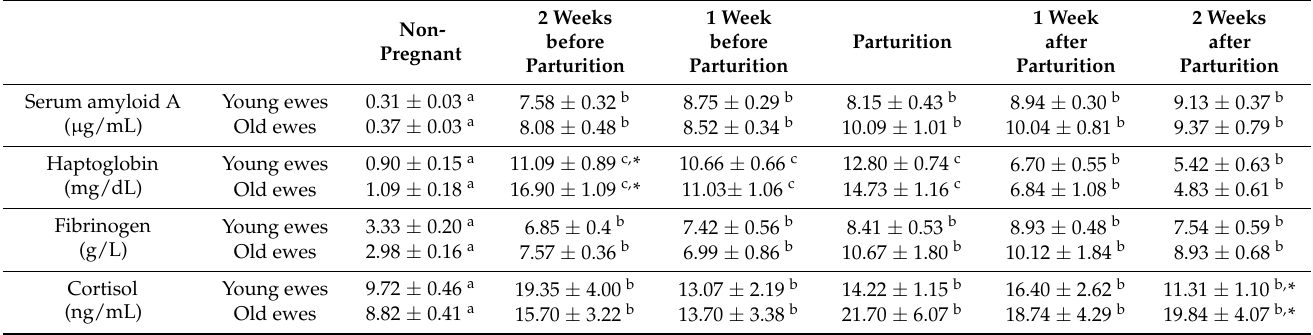
Table 1. Concentration of acute phase proteins and cortisol in blood plasma of ewes ( n = 18).